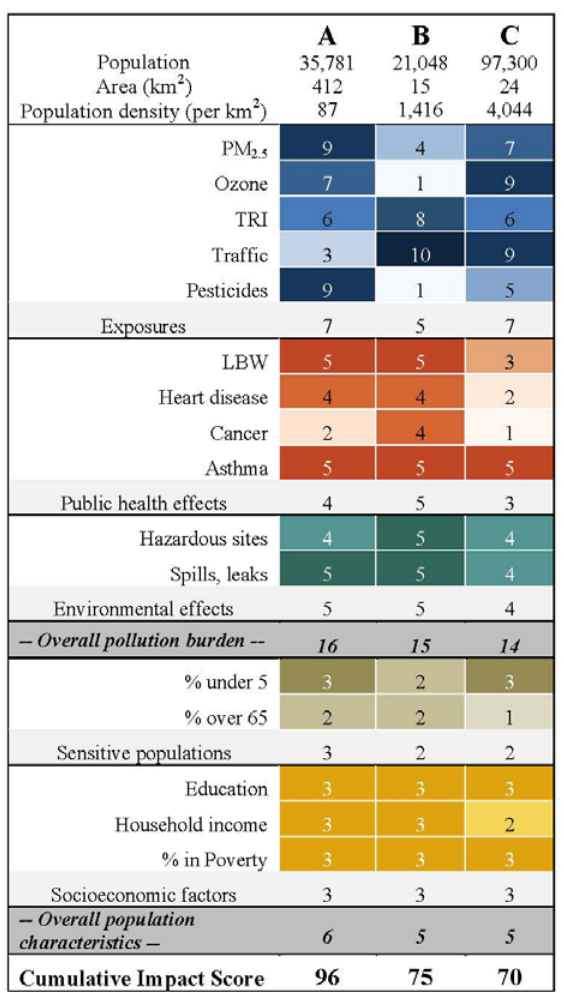
Figure 3. Calculation of the cumulative impact score for three sample